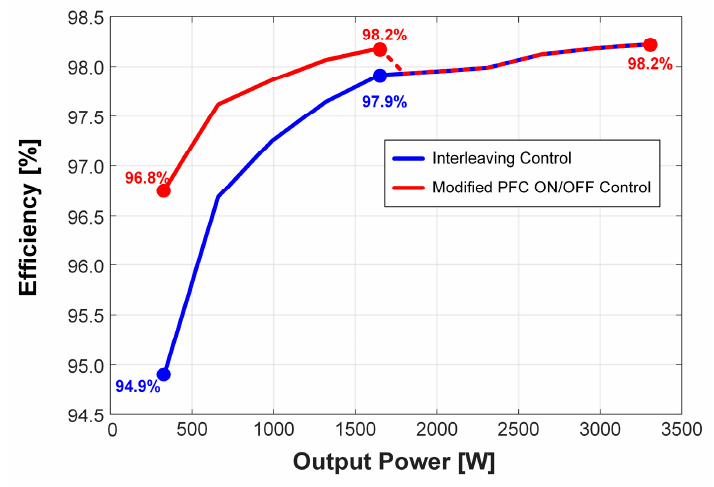
Figure 14. Measured efficiency of the PFC stage with two controls. The FB LLC converter has the same efficiency regardless of the PFC control methods.